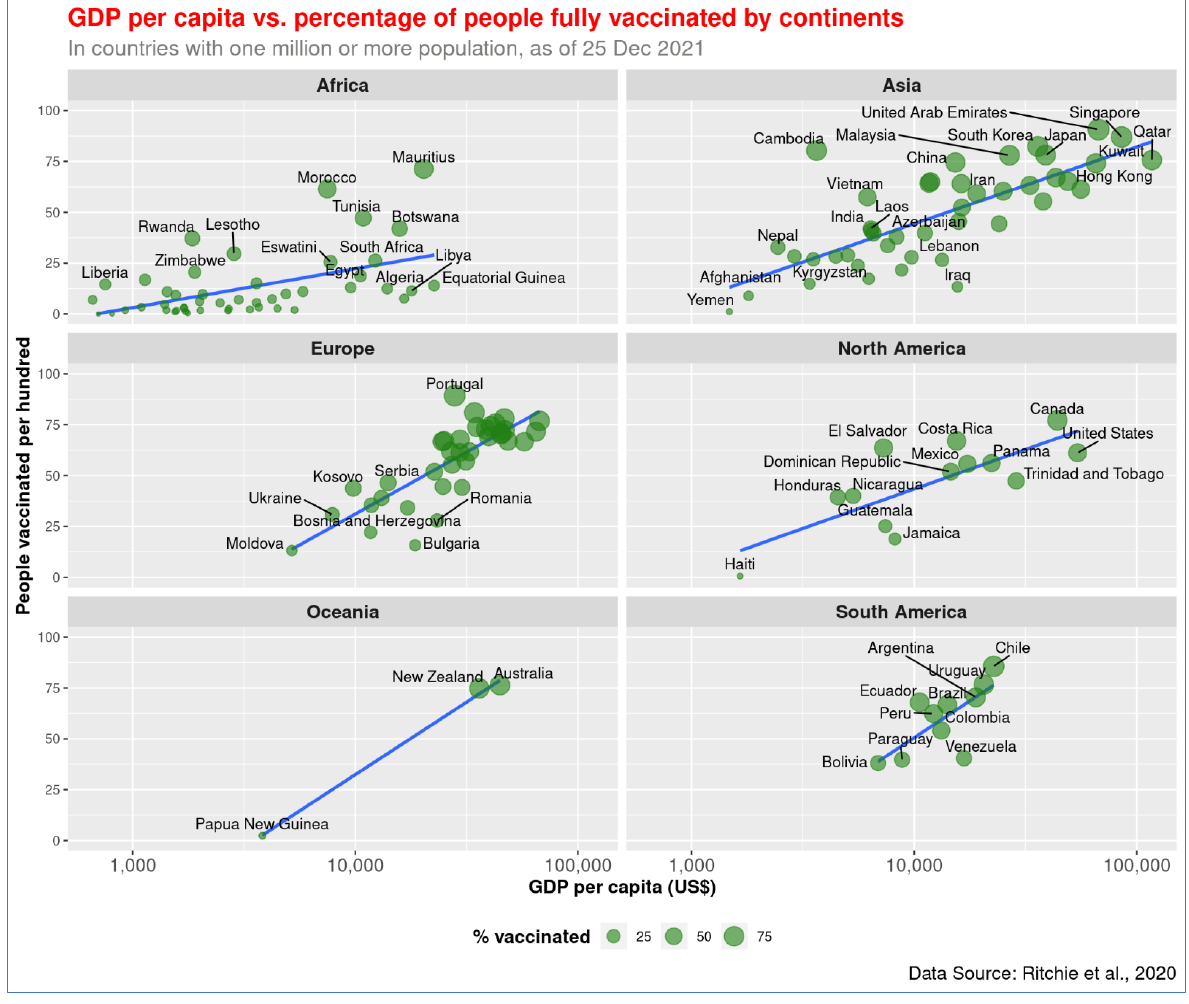
Figure 5. Association of GDP per capita and COVID-19 full vaccination rate across continents. The relationship of both partial and full vaccination rates with GDP is similar in the continents. In Europe, countries with a lower GPS per capita, such as Moldova, Bulgaria, and Bosnia and Herzegovina, obtained 26% or lower vaccination rates. On the other hand, Portugal, Spain, and Denmark achieved over 80% vaccination rates, and their GDP per capita is relatively high. Twenty countries in Europe—including the United Kingdom, France, and Germany—attained 63% or greater vaccination rates, and their GPP is over US$24,000. In Oceania, less developed Papua New Guinea vaccinated about 3% of its peo- ple, while Australia and New Zealand vaccinated over 77% of theirs. Canada (83%) and the United States (USA, 62%) performed the best among the North American countries. Countries like Haiti, Jamaica, and Guatemala managed to vaccinate less than 35% of their population in the same North America continent. In South America, Venezuela appears to have made less progress in vaccination in comparison to its wealth—it managed to vaccinate approximately 64% of its population. The rest of the countries in the continent achieved vaccination rates proportional to their GDP per capita, and Chile and Argentina in South America obtained over 82% vaccination rates. The spatial distribution pattern reveals that African nations are least protected against COVID-19 (Figure 6). North American and European nations made the highest